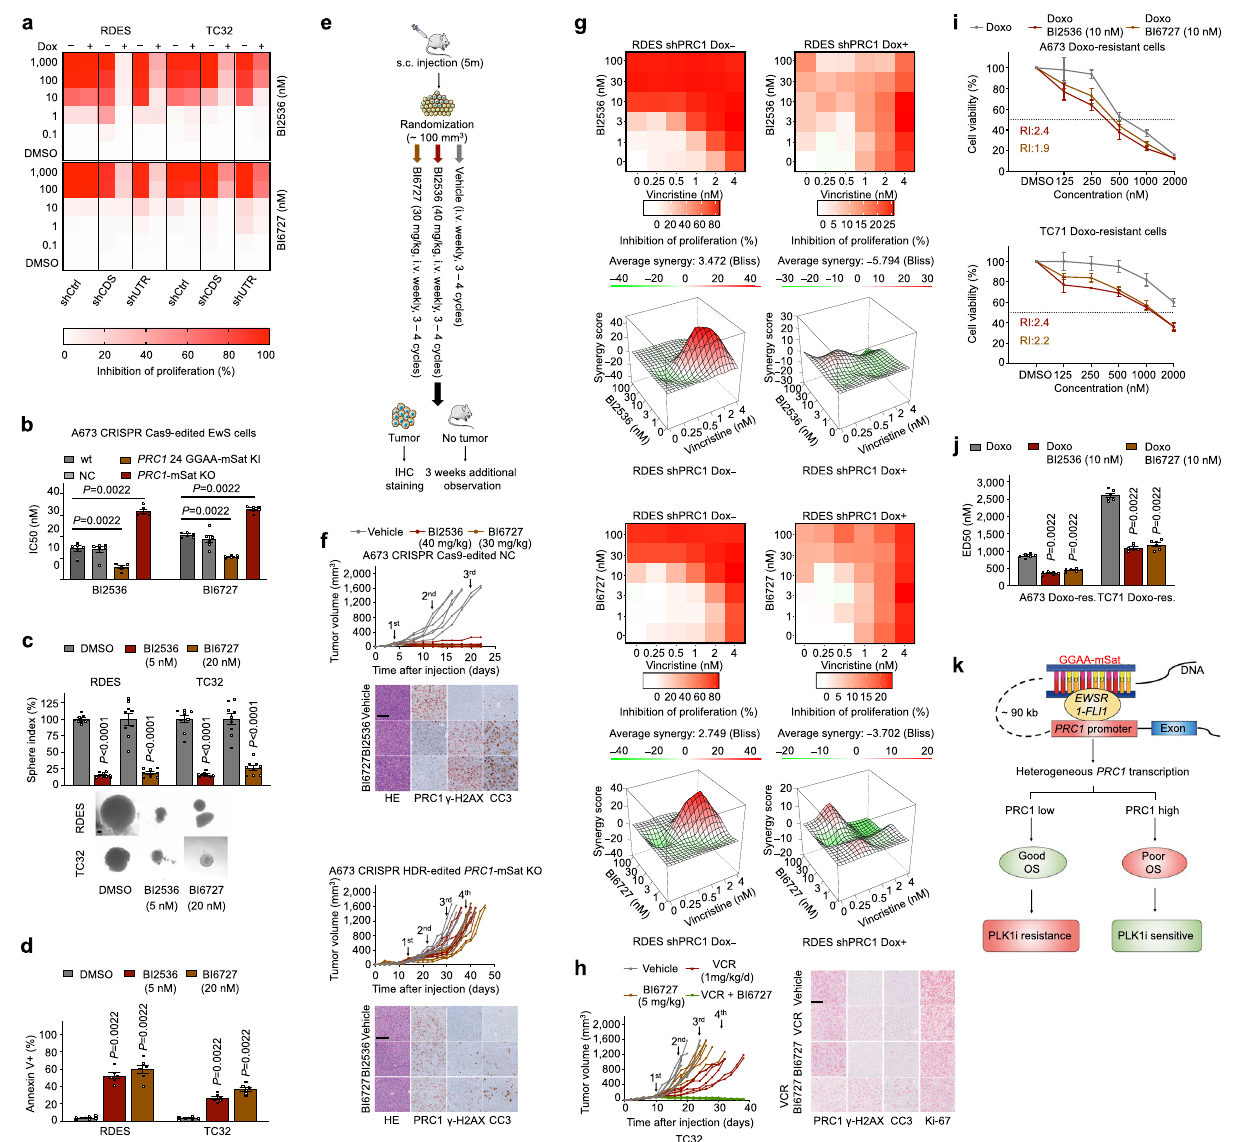
Fig. 4 High PRC1 expression levels prime EwS cells for PLK1 inhibition. a Heatmaps depicting the average percentage of growth inhibition in EwS cells with/without PRC1 silencing after 72 h of PLK1 inhibition; n = 6 biologically independent experiments. b Analysis of IC50 in CRISPR Cas9-edited A673 cells after 72 h of PLK1 inhibition. Data are displayed as individual dots. Horizontal bars represent means and whiskers SEM, n = 6 biologically independent experiments. c Sphere-formation of EwS cells treated with BI2536 or BI6727. Data are displayed as individual dots. Horizontal bars represent means and whiskers SEM, n = 9 biologically independent experiments. Representative images are shown; scale bar = 50 µ m. d Analysis of apoptosis of EwS cells with/ without PLK1 inhibition for 72 h. Data are displayed as individual dots. Horizontal bars represent means and whiskers SEM, n = 6 biologically independent experiments. e Schematic of PLK1 inhibitor treatment in vivo. f Individual tumor volume curves ( n = 6 per condition for NC-cells, n = 7 per condition for KO-cells). Representative micrographs of H&E and PRC1, the positivity of cleaved caspase-3 (CC3), as well as γ -H2AX per HPF. Scale bar = 100 µ m. g Excess over Bliss analysis of RDES cells with/without PRC1 knockdown treated with combinations of Vincristine (VCR) and the PLK1 inhibitors in vitro (red indicates synergy). Summary level (mean) data from n = 6 biologically independent experiments. h Analysis of tumor volume of mice treated with either vehicle, VCR (1 mg/kg/d, i.p.) alone, BI6727 (5 mg/kg, i.v.) alone, or in combination. Representative micrographs of PRC1 staining and positivity of γ